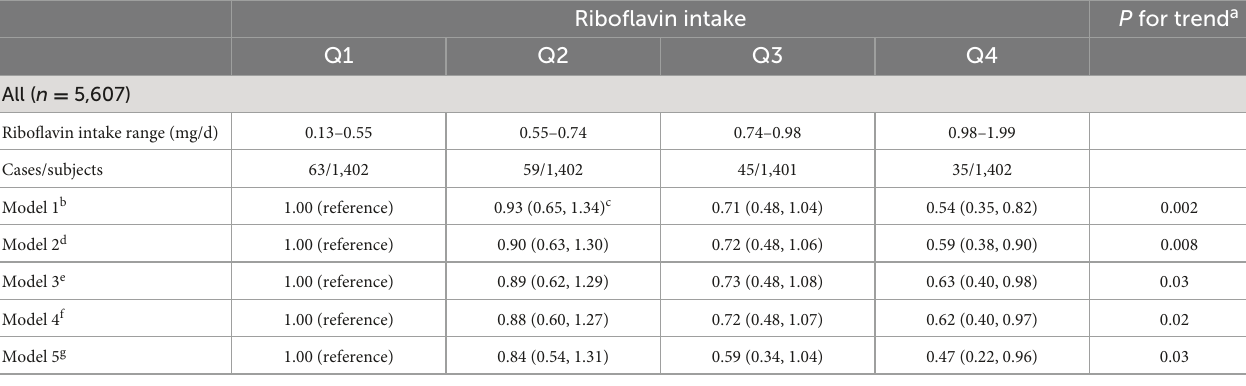
TABLE 3 Relationship between quartiles of riboflavin intake and prevalence of osteoporosis in total population. Riboflavin intake P for trend a